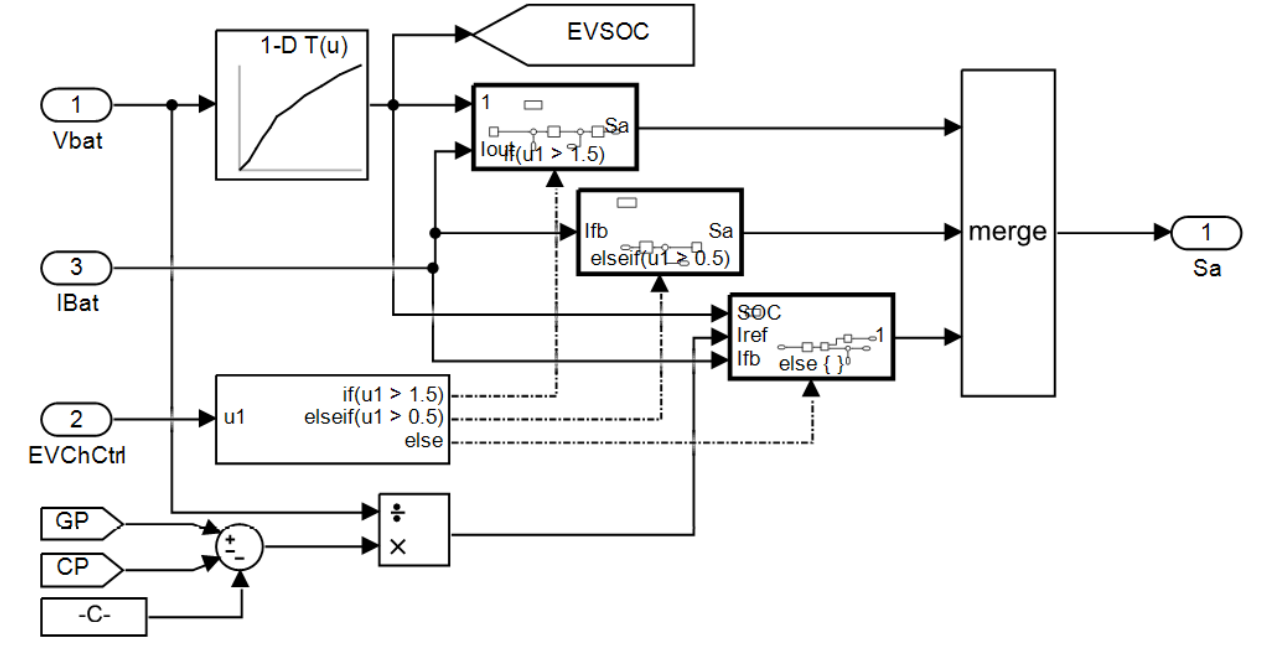
Figure 12. Control algorithm of the vehicle charger.